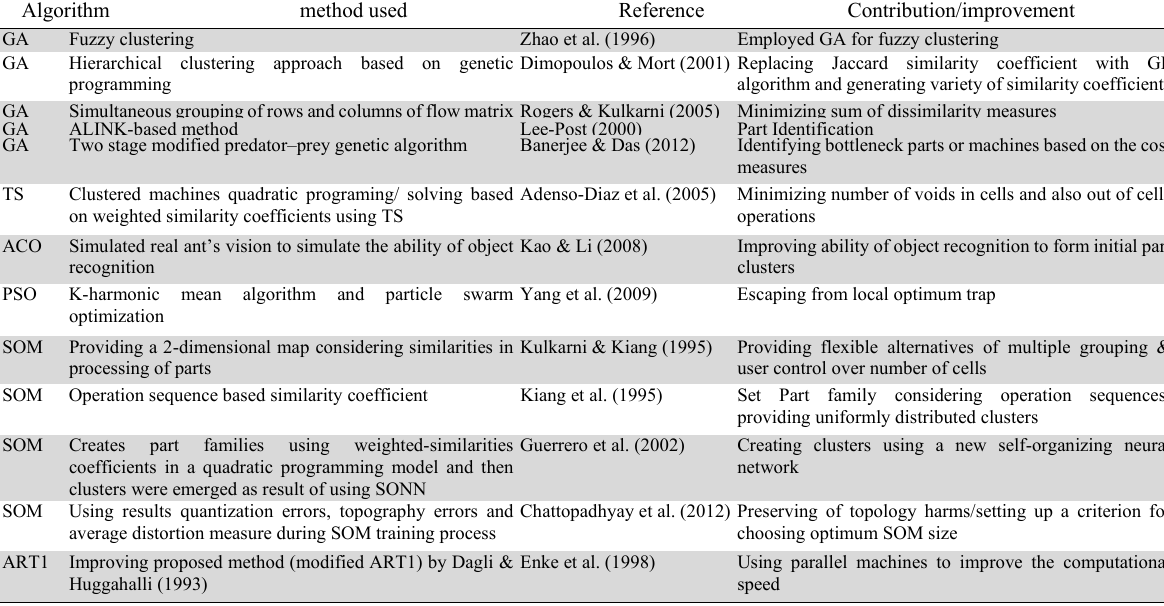
Observations of hybrids of clustering and metaheuristics in CMS